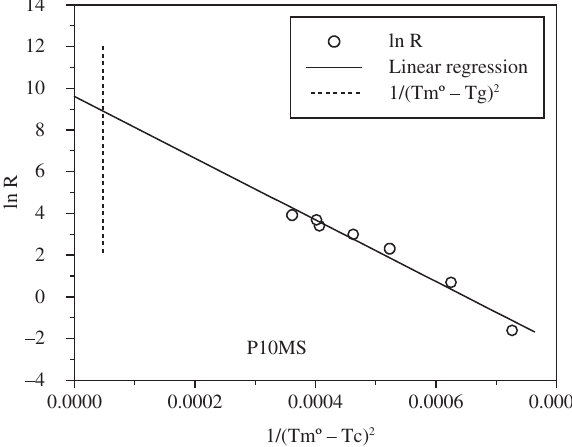
Figure 3. Fitting of the crystallization data to Equation 1 for obtaining the critical cooling rate for vitrification of P10MS. Dotted vertical line represents the undercooling associated to